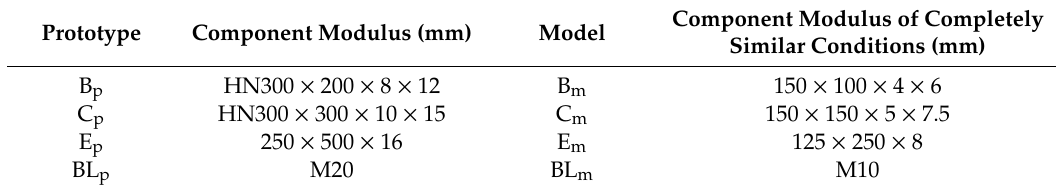
Table 3. Similarity ratio of each factor.